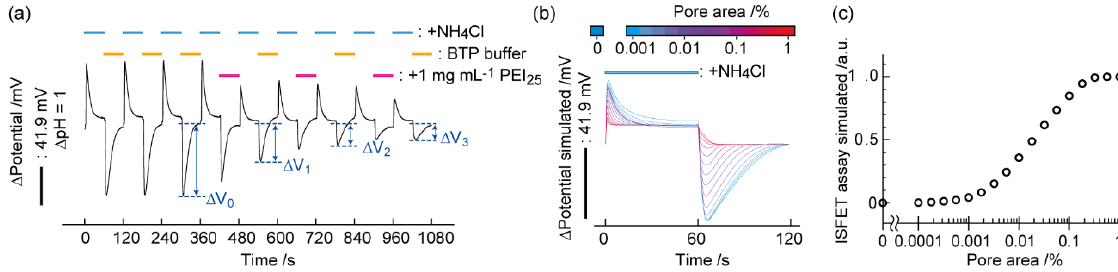
Figure 2. Biomembrane injuries decreased the pH overshoots. ( a ) Time course of the ISFET potential during the intervals of NH 4 Cl loading and unloading with three 1-min exposures of 1 mg/mL [PEI] to the cells. ( b ) Simulation of the ISFET signal during the NH 4 Cl treatment at various ion-accessible pore area percentages (0–1%) of the plasma membranes. ( c ) The reduction rate of the pH overshoot (1 − ∆ V / ∆ V 0 ) as a function of the pore area on the plasma membranes. Reproduced from [46] with permission by Elsevier.